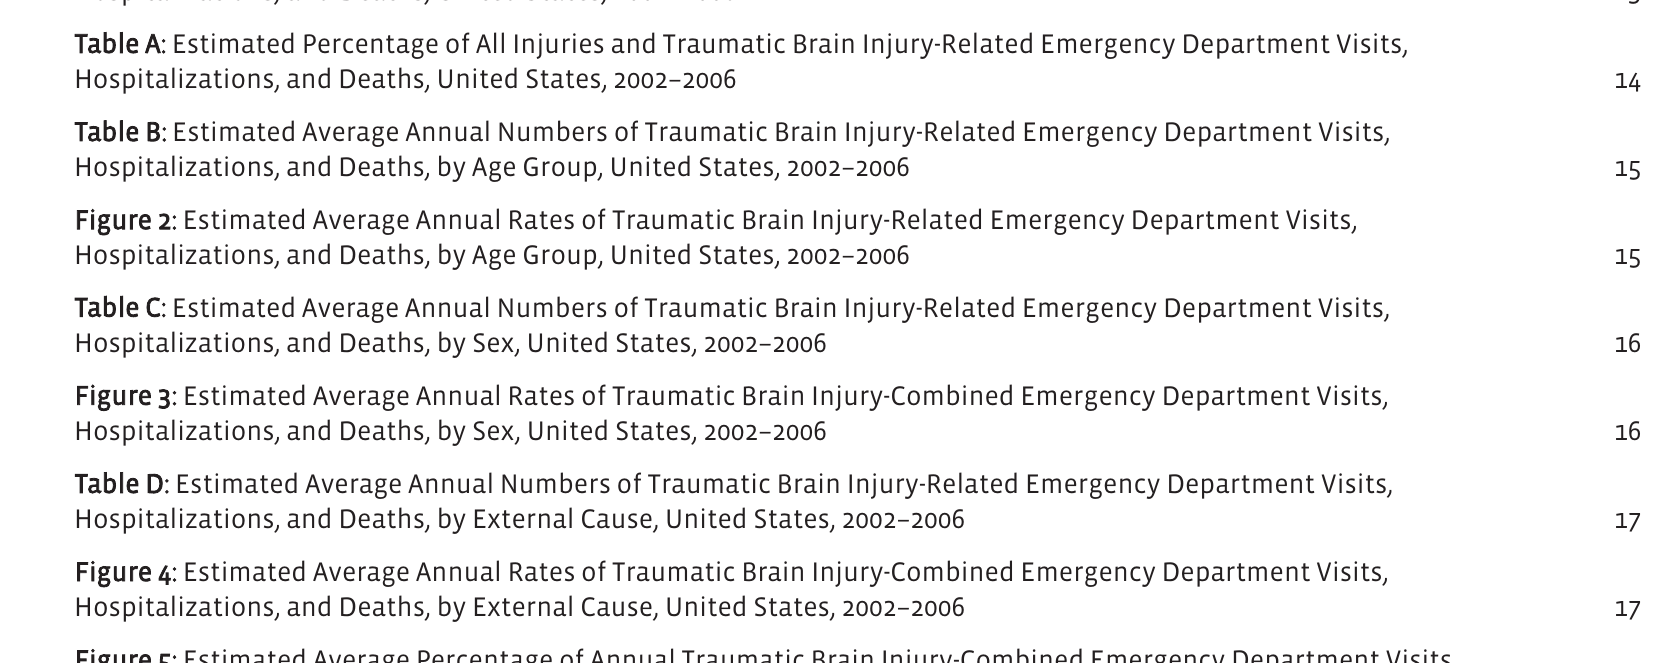
Overview Figure 1: Estimated Average Annual Number of Traumatic Brain Injury-Related Emergency Department Visits, Hospitalizations, and Deaths, United States, 2002–2006 Table A: Estimated Percentage of All Injuries and Traumatic Brain Injury-Related Emergency Department Visits, Hospitalizations, and Deaths, United States, 2002–2006 Table B: Estimated Average Annual Numbers of Traumatic Brain Injury-Related Emergency Department Visits, Hospitalizations, and Deaths, by Age Group, United States, 2002–2006 Figure 2: Estimated Average Annual Rates of Traumatic Brain Injury-Related Emergency Department Visits, Hospitalizations, and Deaths, by Age Group, United States, 2002–2006 Table C: Estimated Average Annual Numbers of Traumatic Brain Injury-Related Emergency Department Visits, Hospitalizations, and Deaths, by Sex, United States, 2002–2006 Figure 3: Estimated Average Annual Rates of Traumatic Brain Injury-Combined Emergency Department Visits, Hospitalizations, and Deaths, by Sex, United States, 2002–2006 Table D: Estimated Average Annual Numbers of Traumatic Brain Injury-Related Emergency Department Visits, Hospitalizations, and Deaths, by External Cause, United States, 2002–2006 Figure 4: Estimated Average Annual Rates of Traumatic Brain Injury-Combined Emergency Department Visits, Hospitalizations, and Deaths, by External Cause, United States, 2002–2006 Figure 5: Estimated Average Percentage of Annual Traumatic Brain Injury-Combined Emergency Department Visits, Hospitalizations, and Deaths, by External Cause, United States, 2002–2006 Figure 6: Estimated Average Percentage of Annual Traumatic Brain Injury-Combined Emergency Department Visits, Hospitalizations, and Deaths Among Children 0 to 14 Years, by External Cause, United States, 2002–2006 Figure 7: Estimated Average Percentage of Annual Traumatic Brain Injury-Combined Emergency Department Visits, Hospitalizations, and Deaths Among Adults 65 Years and Older, by External Cause, United States,